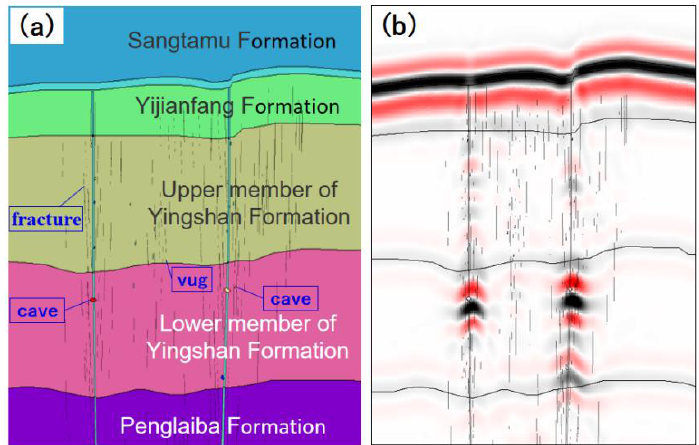
Figure 9. A geological model and forward modeling section of the fault-controlled fracture cave reservoir. ( a ) fault-controlled fracture cave reservoir geologic model; ( b ) the profile of fault-controlled fracture cave model superimposed on forward simulation results.